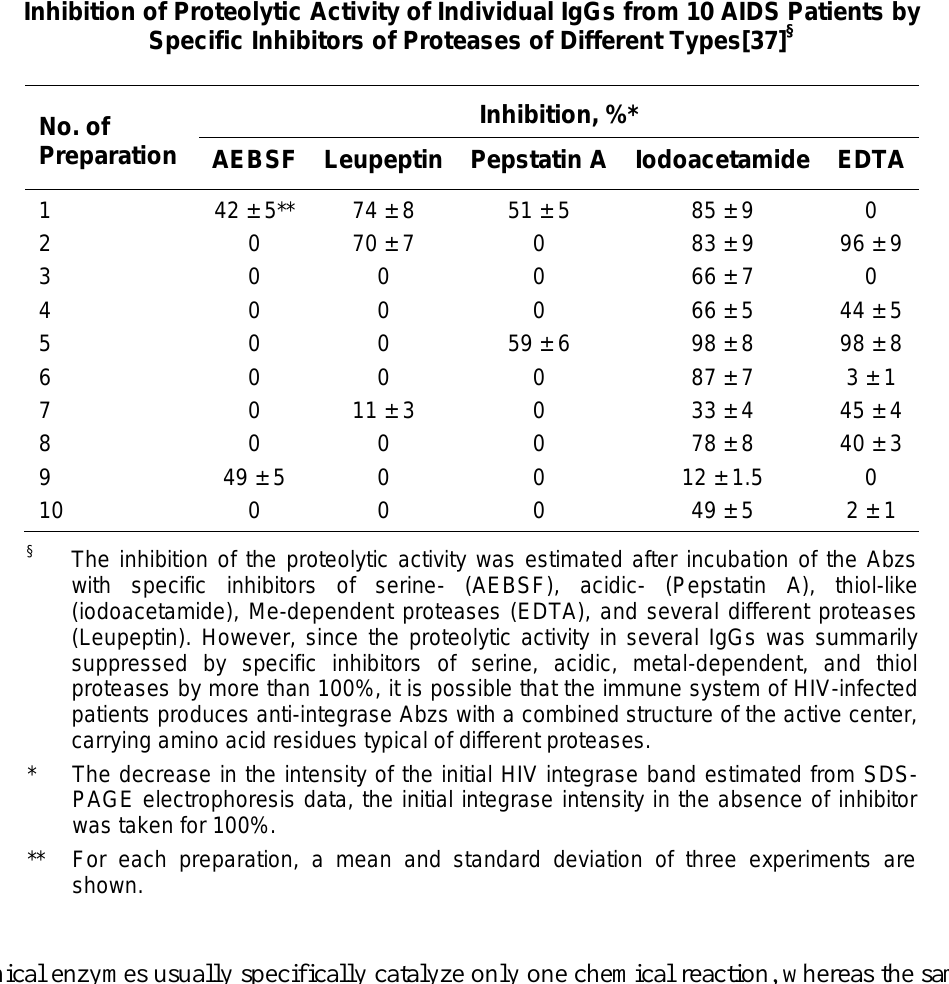
No. of Preparation